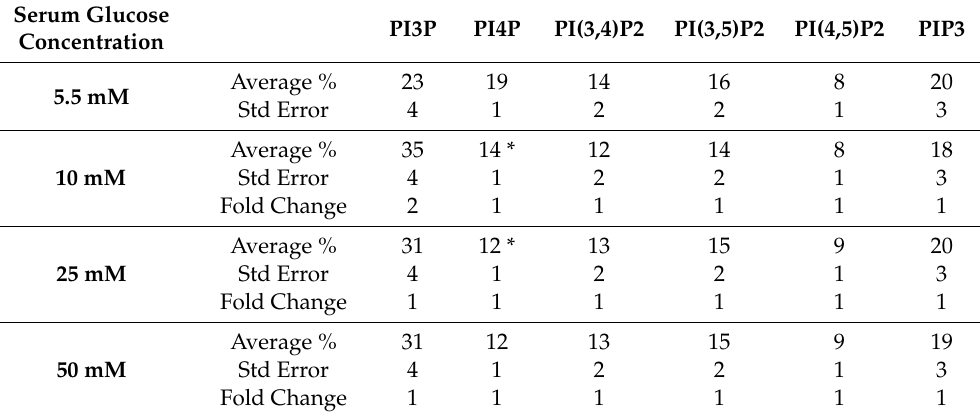
Figure 6. Effect of glucose concentration on HER2+ breast cancer total PI phosphorylation. The % of total PI lipid PI3P, PI4P, PI(3,4)P2, PI(4,5)P2, PI(3,5)P2, and PIP3 from SKBR3 cells incubated in 5.5 mM, 10 mM, 25 mM, and 50 mM serum glucose concentrations, measured by spot blot analysis ( n = 3). Table 4. Statistical analysis of whole cell lipidome in SKBR3 cell line.